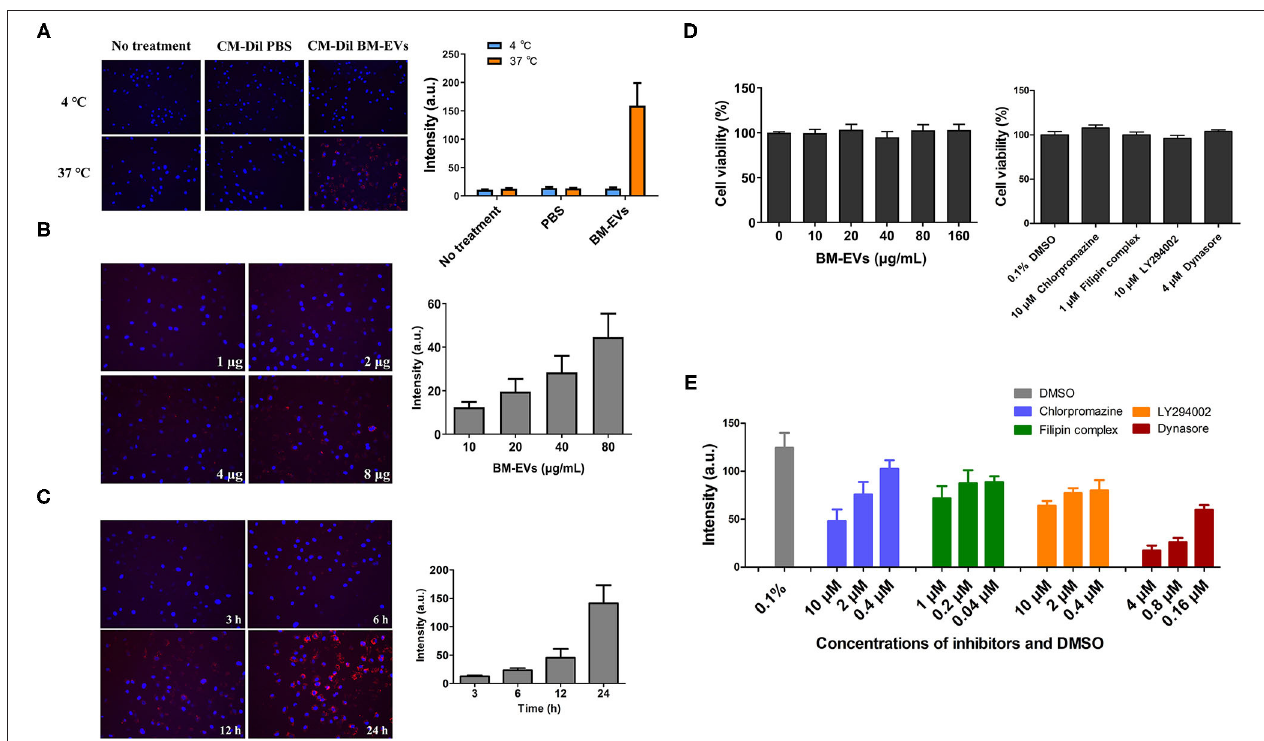
FIGURE 4 | Cellular uptake and cytotoxicity of BM-EVs. (A) HUVECs were incubated with 20 µ g CM-Dil labeled BM-EVs (red) at 37 or 4 ◦ C and monitored after 3h. The cells were untreated or treated with CM-Dil PBS as a negative control. Nuclei were visualized by staining with DAPI (blue). Representative images are shown (left panel) and fluorescent intensity of CM-Dil labeled BM-EVs was quantified using Image-Pro Plus software (right panel; n = 3, mean ± standard deviation). (B) CM-Dil labeled BM-EVs at 0-80 µ g/mL were added to HUVECs in a 96-well plate and monitored after 12h ( n = 3, mean ± standard deviation). (C) CM-Dil labeled BM-EVs were added at 80 µ g/mL and monitored after 3, 6, 12, and 24h ( n = 3, mean ± standard deviation). (D) Cytotoxicity of BM-EVs (left panel) and inhibitors (right panel) in vitro : HUVECs were treated with BM-EVs or inhibitors for 12h in a conventional incubator ( n = 4, mean ± standard deviation). (E) The uptake of CM-Dil labeled BM-EVs (10 µ g) was assessed after 12h in the presence of 0.1% DMSO, chlorpromazine (hydrochloride), filipin complex, LY294002, and dynasore ( n = 3, mean ± standard deviation). All images were observed using 200 × fluorescence